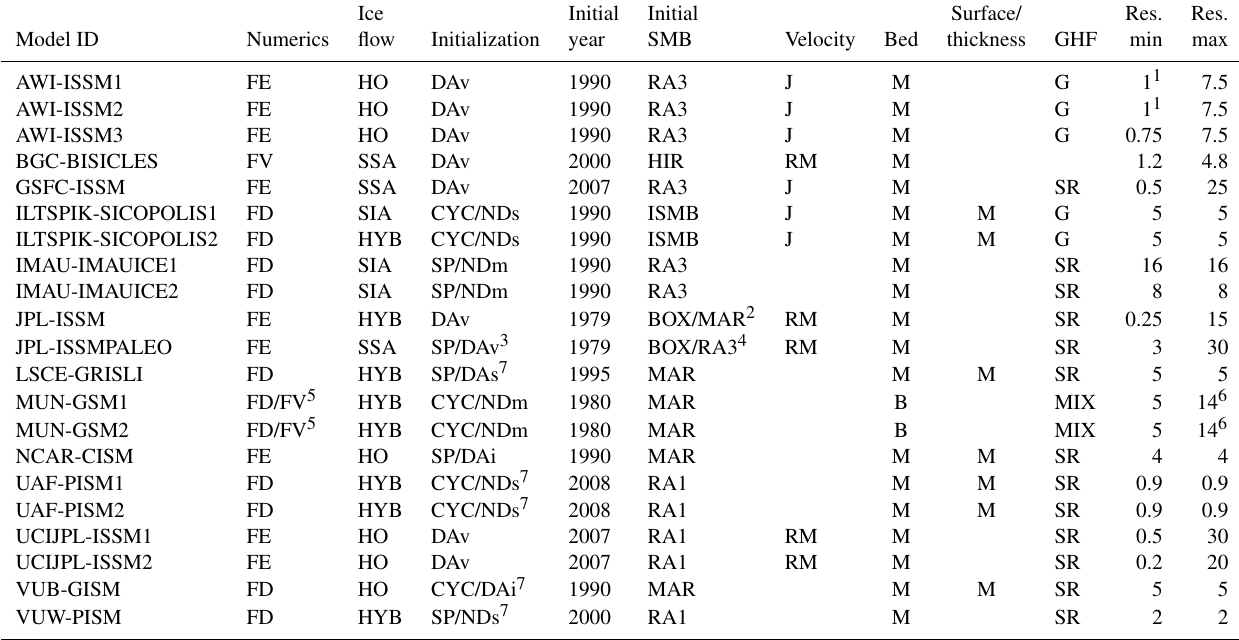
Table A1. Model characteristics. The numerical method is as follows. FD: finite difference; FE: finite element; FV: finite volume with adaptive mesh refinement. The ice flow is as follows. SIA: shallow-ice approximation; SSA: shallow-shelf approximation; HO: higher order; HYB: SIA and SSA combined. The initialization method is as follows. DAv: data assimilation of velocity; DAs: data assimilation of surface elevation; DAi: data assimilation of ice thickness; SP: spin-up; CYC: transient glacial cycle(s); NDm: nudging to ice mask; NDs: nudging to surface elevation. The initial SMB is as follows. RA1: RACMO2.1; RA3: RACMO2.3; HIR: HIRHAM5; MAR: MAR; BOX: BOX reconstruction (synthesis of simulation and data); ISMB: implied SMB. Velocity is as follows. RM: Rignot and Mouginot; J: Joughin et al. Bed and surface are as follows. M: Morlighem et al.; B: Bamber et al. Geothermal heat flux (GHF) is as follows. SR: Shapiro and Ritzwoller; G: Greve; MIX: see individual model description. Model resolution (Res) in kilometres. In case of heterogeneous grid resolution, the minimum and maximum resolutions are